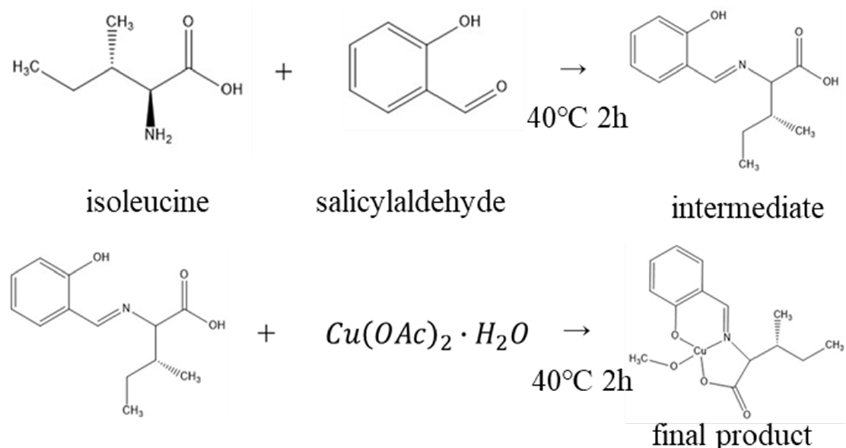
Figure 1. Synthesis reaction of an amino acid Schiff base copper(II) complex.